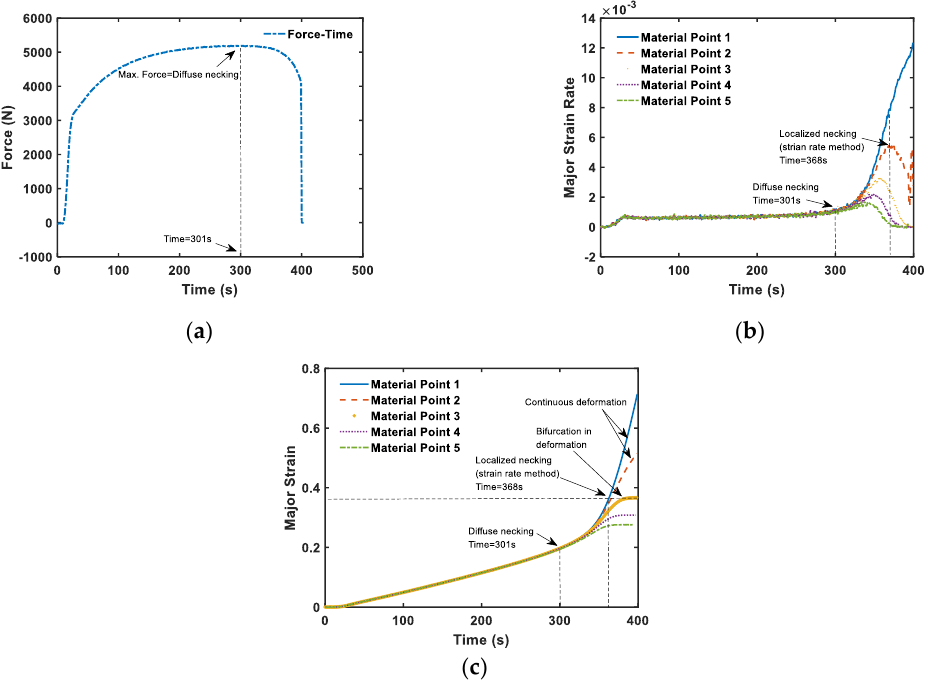
Figure 5. Force, major strain rate, and major strain evolution during uniaxial tension test of a high- strength steel sheet: ( a ) force – time evolution; ( b ) major strain rate evolution; ( c ) major strain evolu- tion.